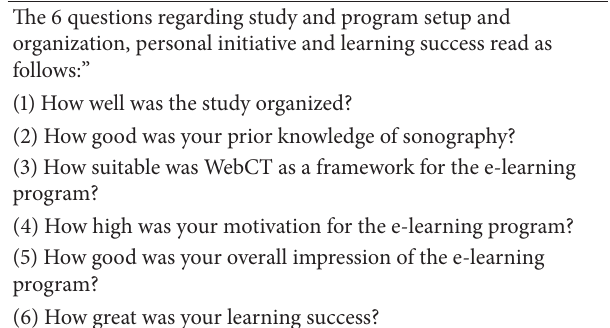
Table 2: Questions of qualitative evaluation survey of the e-learning program using the internet tool Survey Monkey. Questions were scaled discretely from 0 to